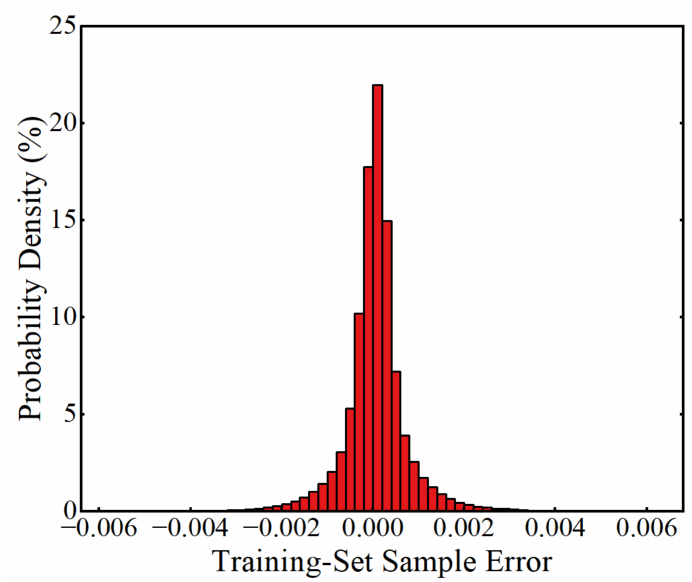
Figure 14. Probability density of the errors in predicting the training-set